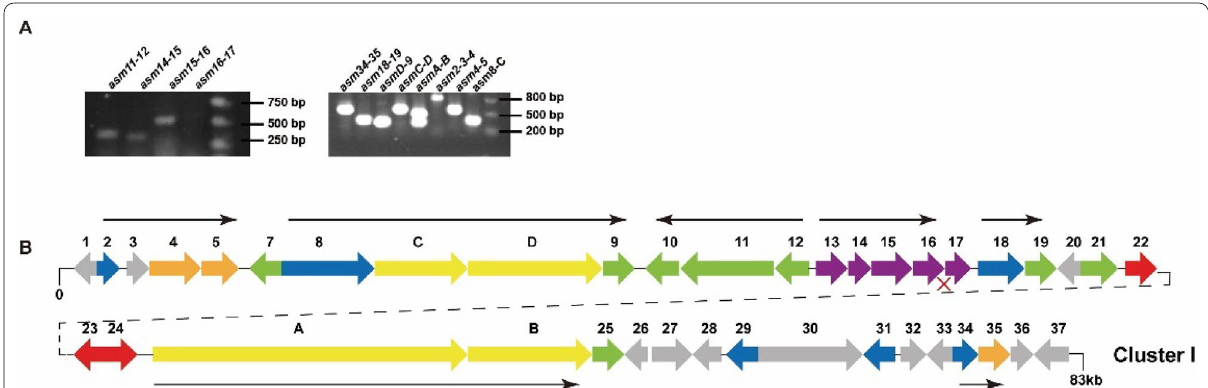
Fig. 9 Transcript assay of AP-3 biosynthetic gene cluster ( A ) and transcription unit distribution ( B ). A RNA sample was isolated from day 3 culture of strain L40. RT-PCR fragments were shown. ( asm11-12 , 374 bp; asm14-15 , 341 bp; asm15-16 , 513 bp; asm16-17 , 435 bp; asm8-C , 362 bp; asm2-3-4 , 854 bp; asm4-5 , 566 bp; asmC-D , 589 bp; asmD-9 , 348 bp; asmA-B , 482 bp; asm18-19 , 402 bp; asm34-35 , 617 bp). B Horizontal black arrows show the transcription unit confirmed by RT-PCR. ‘x’, no mRNA connecting the genes. asm11 shares 4 bp with asm10 , asm13 shares 4 bp with